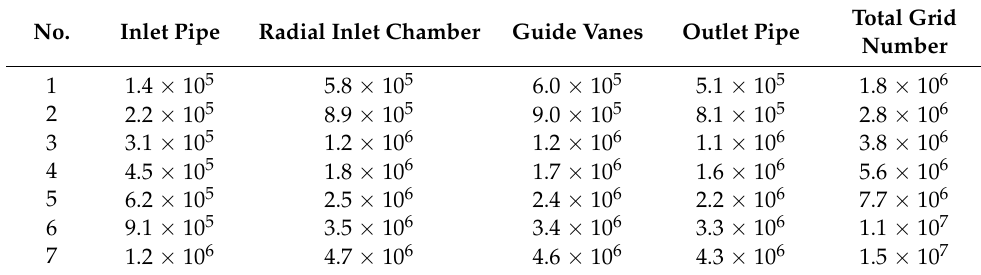
Table 2. Verification schemes for the convergence study.